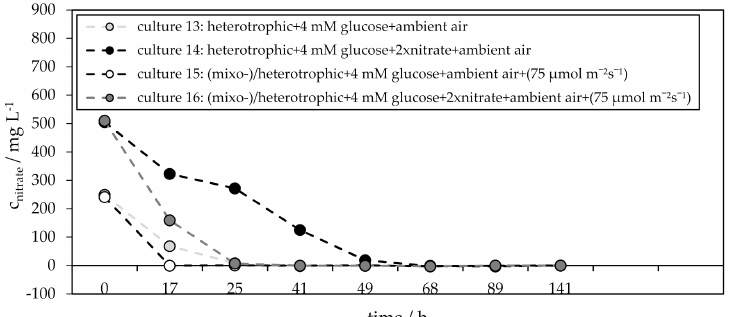
Figure 16. Time course of the nitrate concentration heterotrophic culture 13 (heterotrophic + 4 mM glucose + ambient air) and culture 14 (heterotrophic + 4 mM glucose + 2xnitrate + ambient air), and culture 15 (mixo-/heterotrophic + 4 mM glucose + ambient air + (75 µ mol m − 2 s − 1 ) and culture 16 (mixo-/heterotrophic + 4 mM glucose + 2xnitrate + ambient air + (75 µ mol m − 2 s − 1 ); data obtained by single